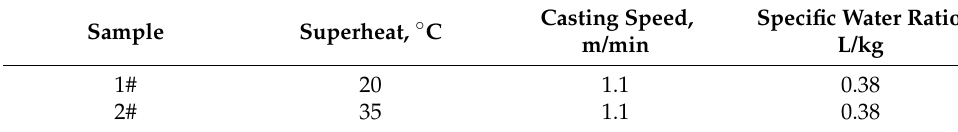
Table 1. Main continuous casting process parameters of GCr15 steel